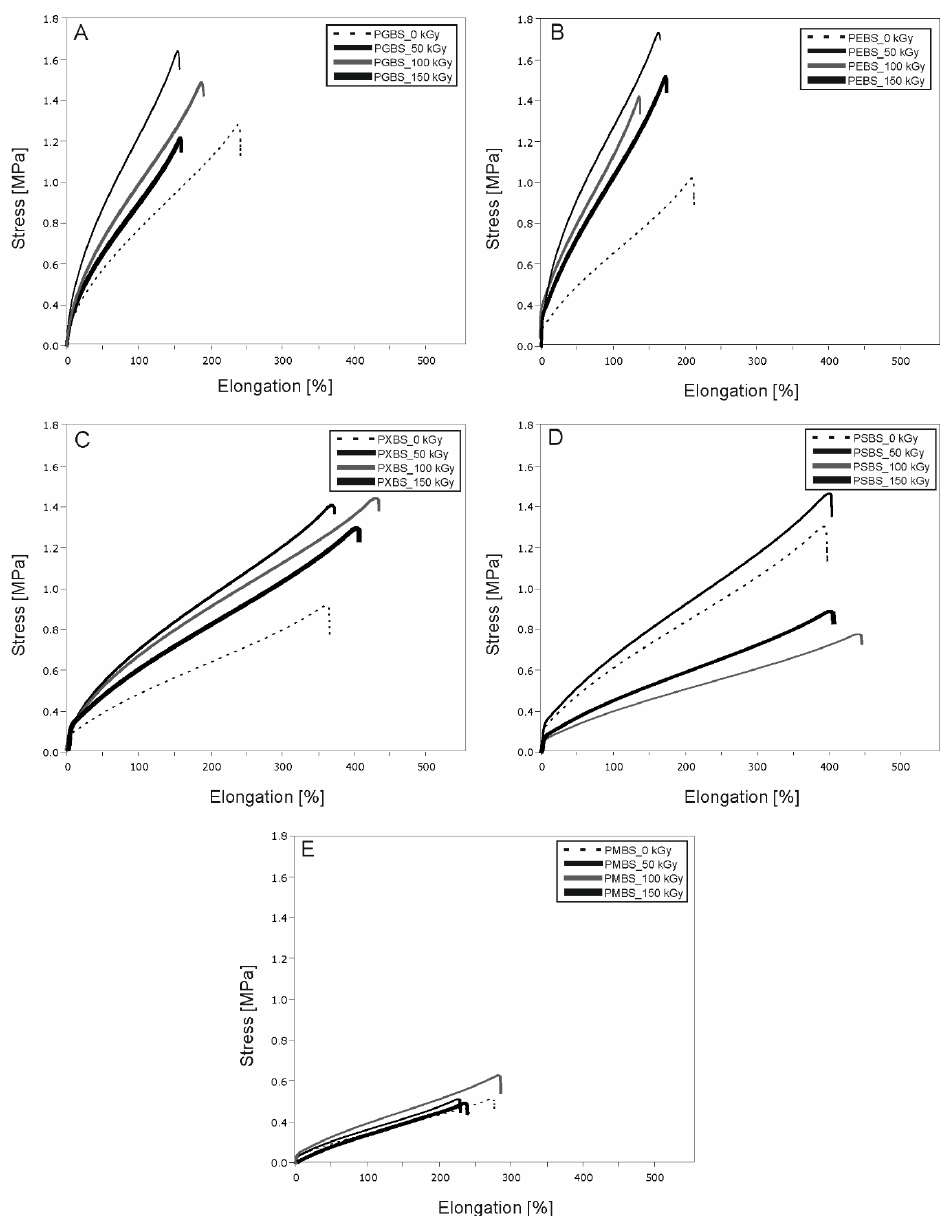
Figure 6. Mechanical properties of ( A ) PGBS, ( B ) PEBS, ( C ) PXBS, ( D ) PSBS, and ( E ) PMBS before and after irradiation.